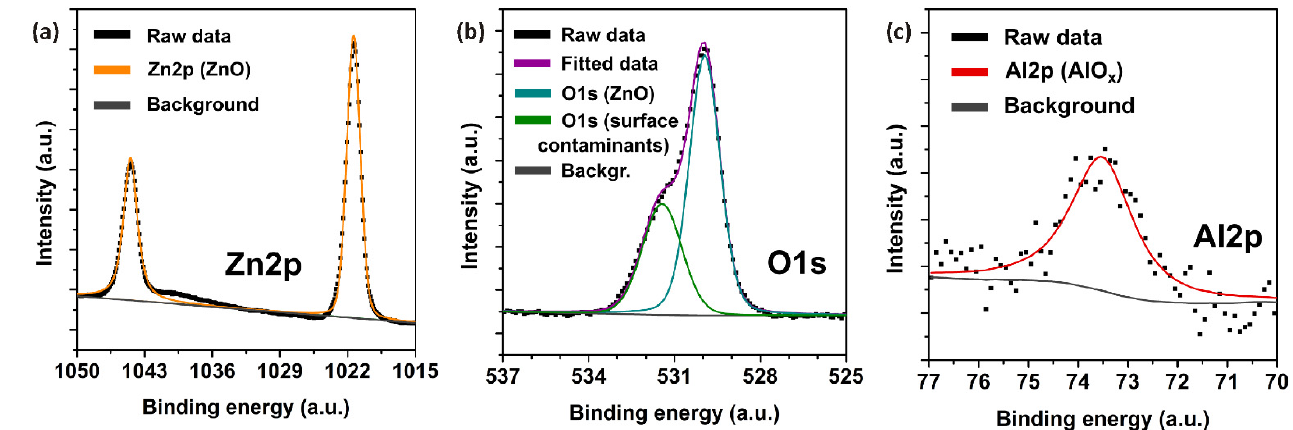
Figure 2. High-resolution XPS spectra and peak fits of the Al:ZnO thin film: ( a ) Zn 2p scan, ( b ) O 1s scan, and ( c ) Al 2p scan.